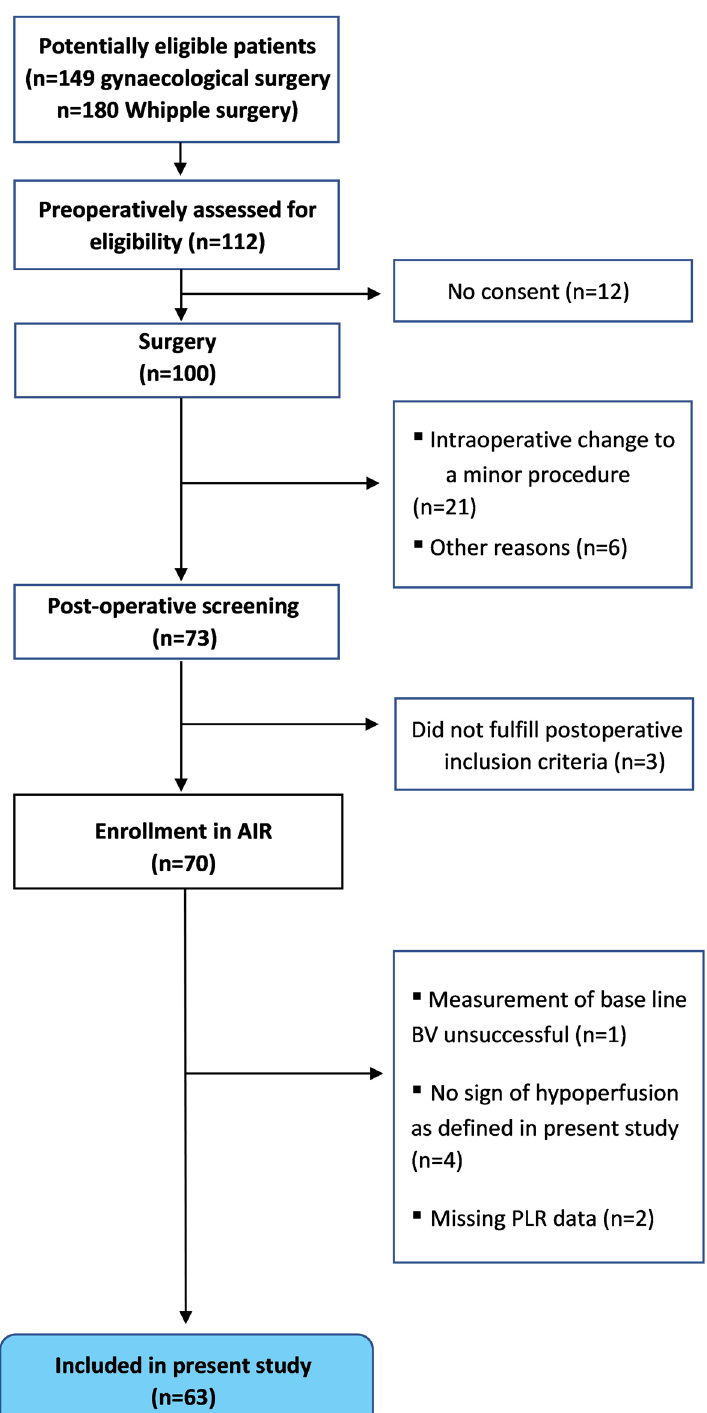
Fig. 1 Flowchart of eligible, enrolled and analyzed